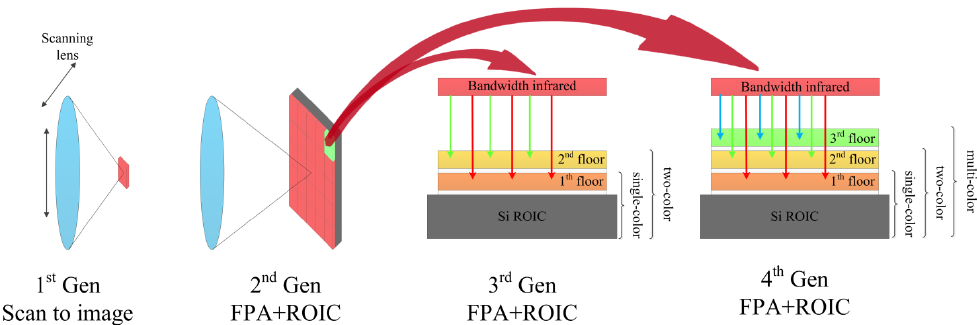
Figure 1. The development roadmap of infrared detectors. Through scan to image and single-color FPA towards two-color and multi-color.